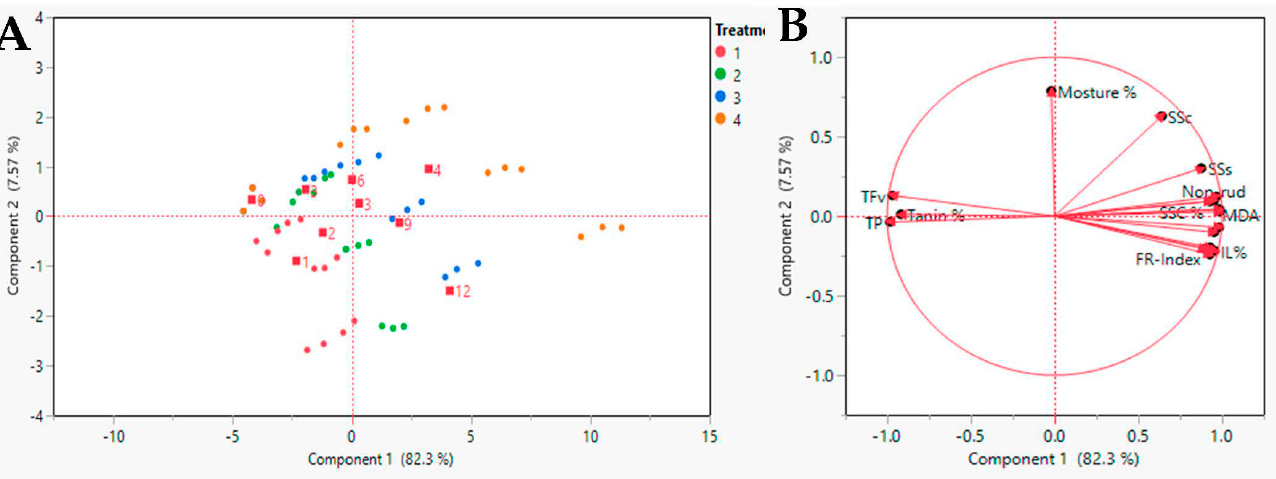
Figure 7. Presents the Principal Component Analysis (PCA) representing shelf-life duration in days and ATP (four) to ‘Zaghloul’ date, plotted with the contribution of each parameter on the four PCA axes ( A ), and all the physiological and biochemical parameters measured in fruit during the storage period ( B ). Principal Component Analysis (PCA) variable correlation.